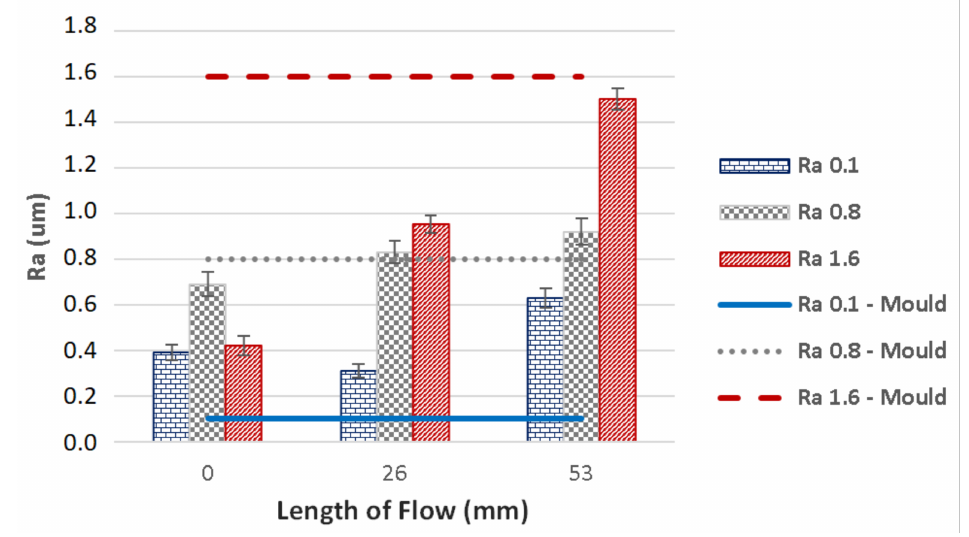
Figure 11. Dependence of the flow length on the surface quality of the mould and the product— injection pressure 400 bar.